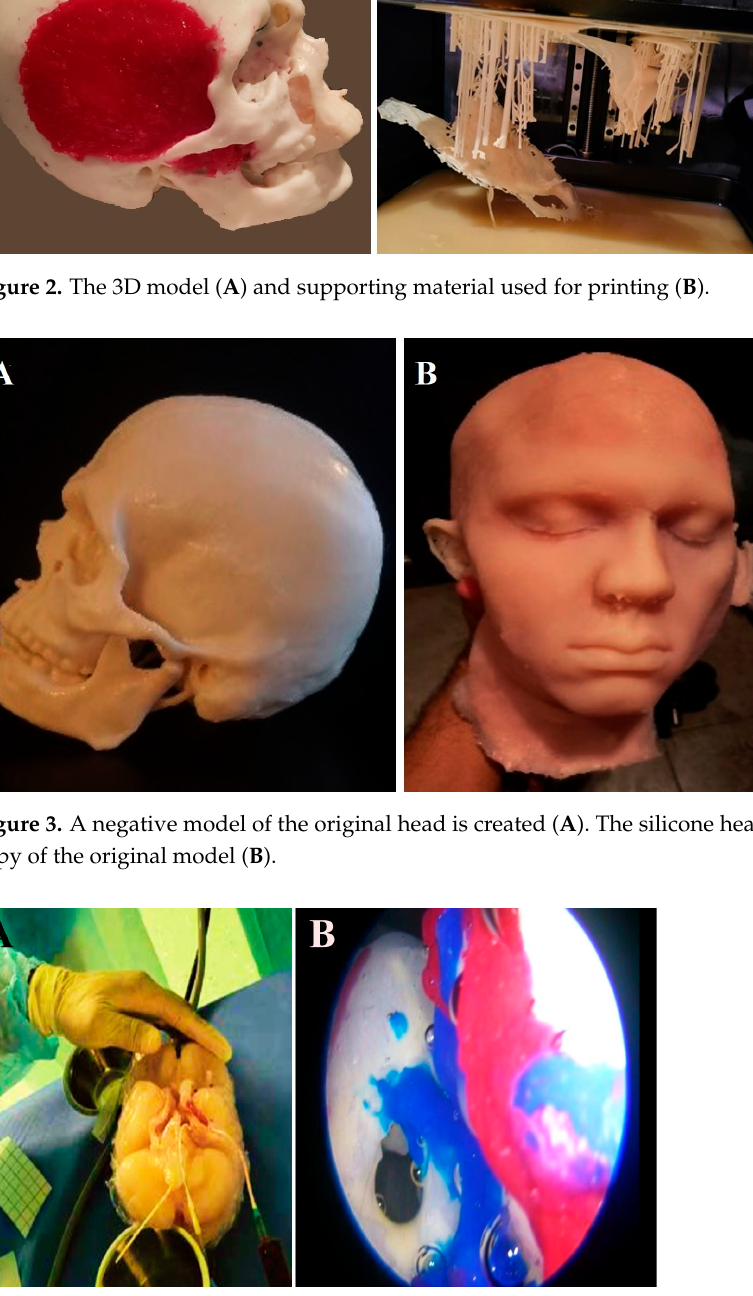
Figure 4. The synthetic dura mater is wrapped around the silicone brain ( A ). The model has a closed-circuit system that provides liquid flow inside the ventricles. Several layers mimic cutaneous, muscular, bony, and dural consistency. Intraventricular view showing foramen of Monro and thalamostriate veins ( B ).